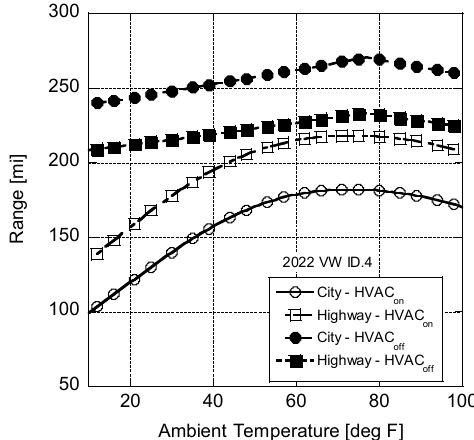
Figure 20. Estimated range of the 2022 VW ID.4 vehicle as a function of ambient temperature with the HVAC system off and on.